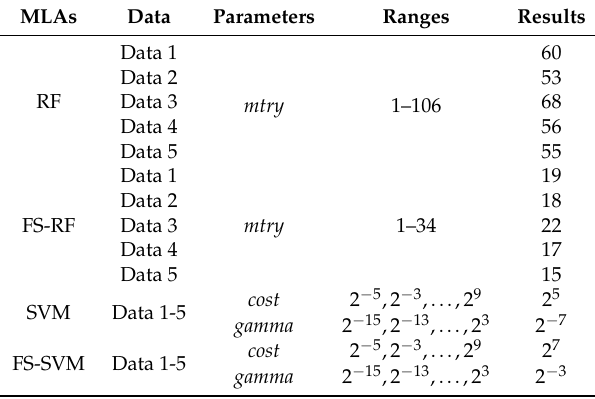
Table 5. Parameter optimization results for machine learning algorithm-based models. RF: random